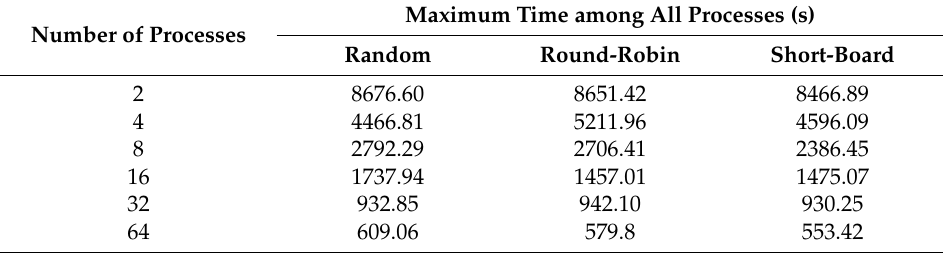
Table 4. Profiling of different load balancing